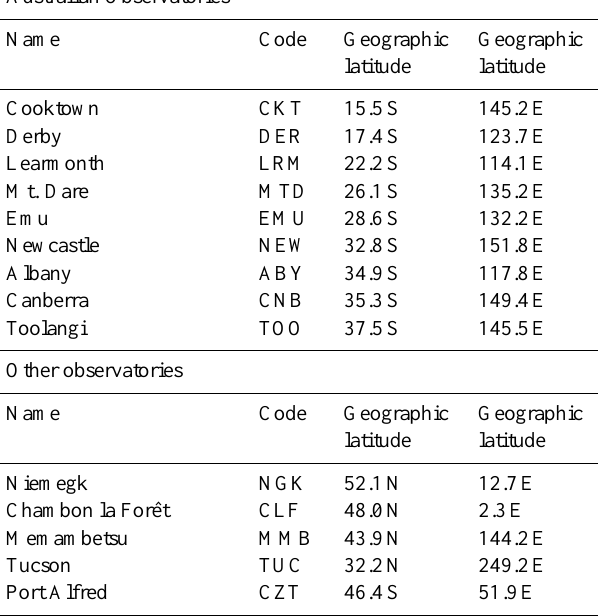
Table 1. Coordinates of observatories